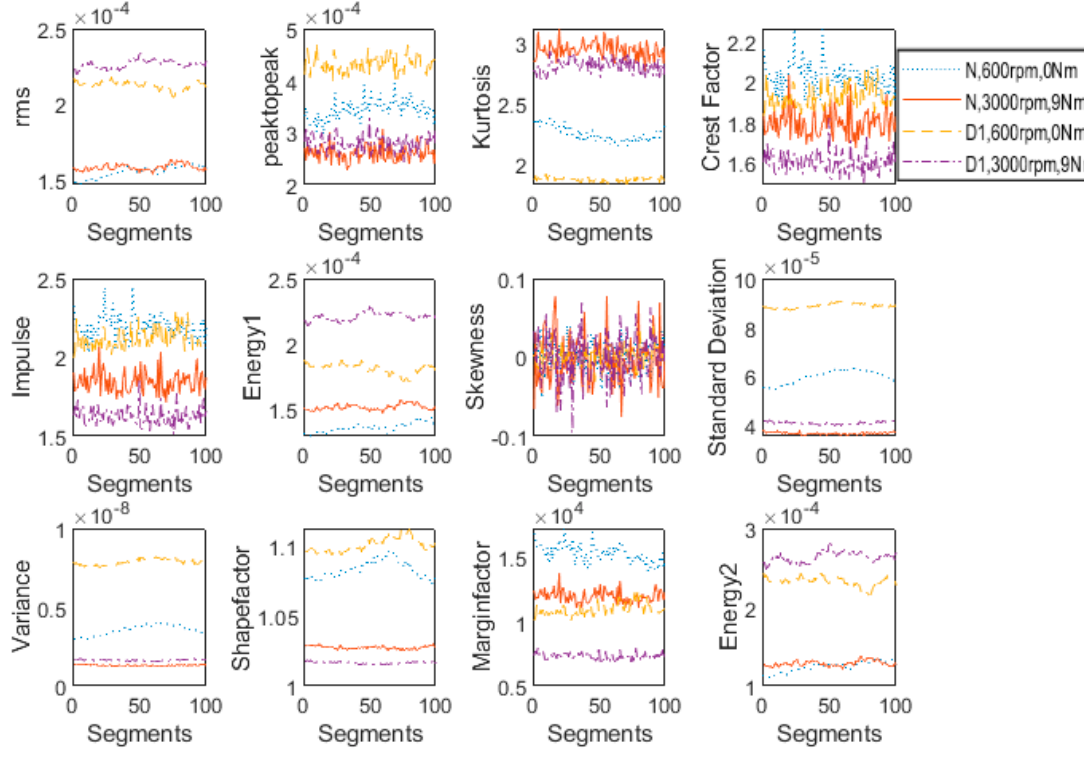
Figure 9. Features’ plot for normal and 1 tooth broken gear boxes at extreme operating conditions.